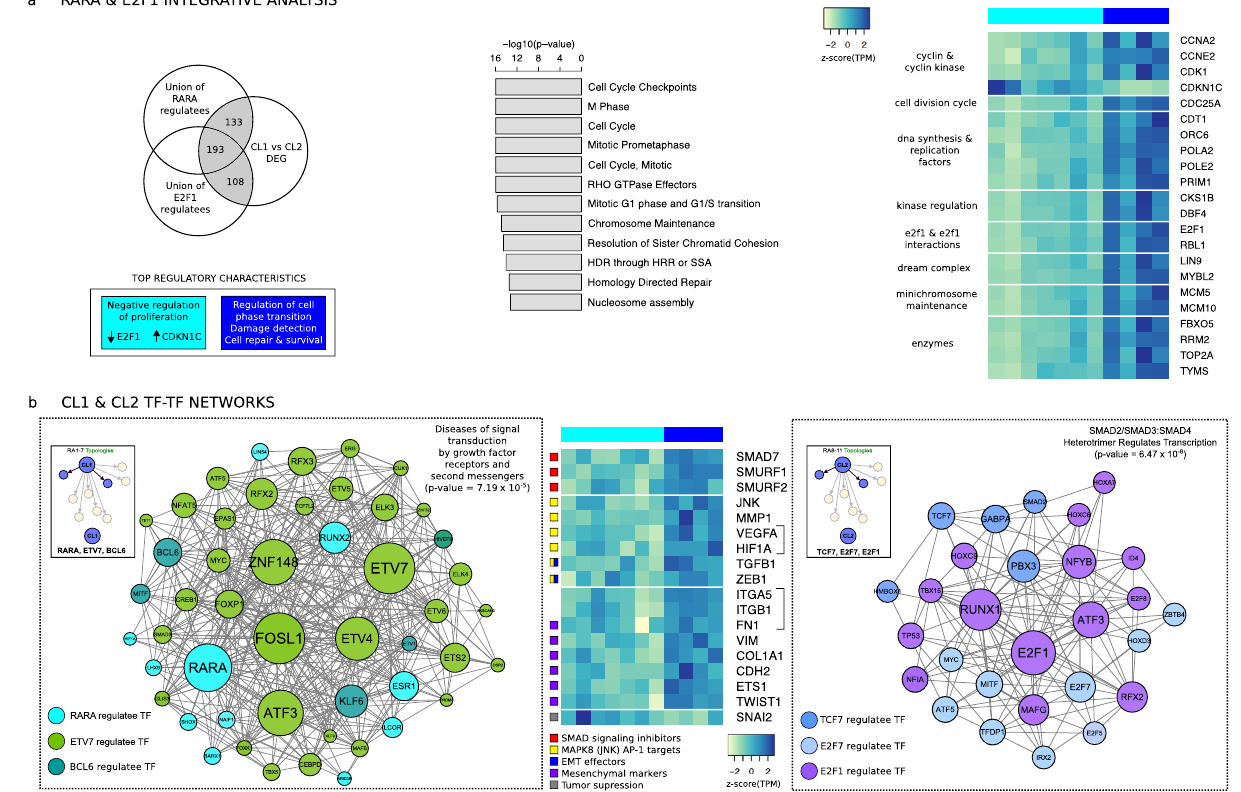
Fig. 3 | Network analysis for top cluster-speci fi c TFs shows differential reg- ulation of cell proliferation mechanisms and an imprinted TGF β -driven EMT signature in CL2. a Union of RAR α and E2F1 regulatees across all RA patient transcriptional networks intersected with CL1 vs CL2 2-fold ( p <0.05 by two- sided Student t-test) differentially expressed genes (DEGs). Functional enrich- ment analysis of high edge weight TF-speci fi c DEG regulatees and RAR α /E2F1 union DEG regulatees. Heatmap of gene expression (z-score(TPM)) for genes fromselectedpathway “ MitoticG1phaseandG1/Stransition ” . b Representation